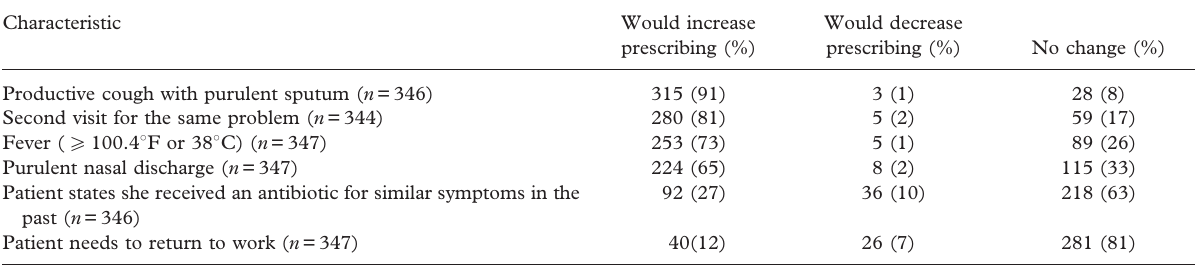
Table IV. *The influence of various patient characteristics on the likelihood of provider antibiotic prescribing for a non-pregnant woman with a URI, etiology unknown. Characteristic Would increase